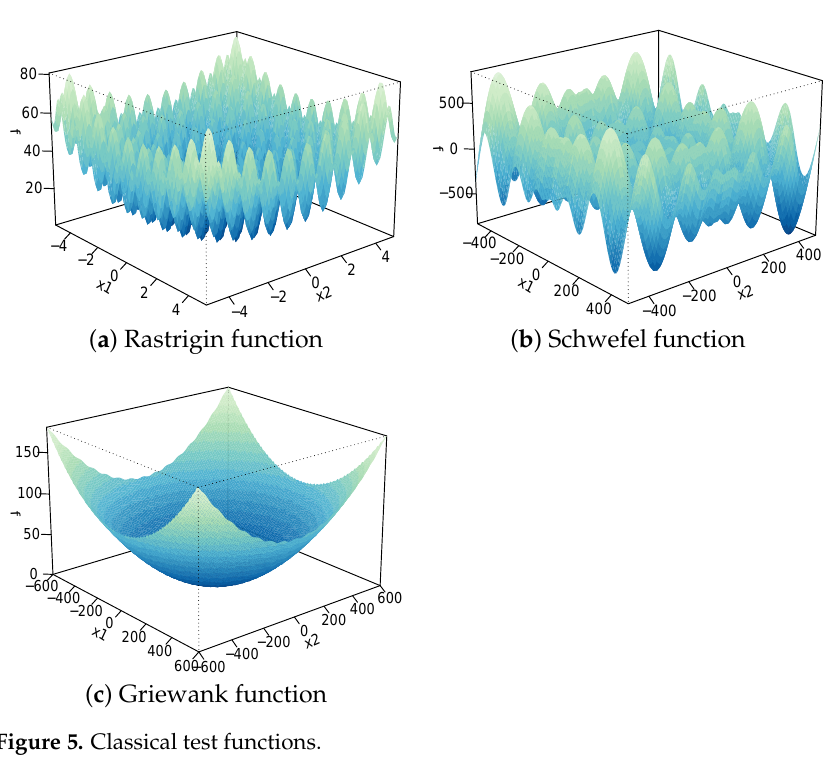
Figure 5. Classical test